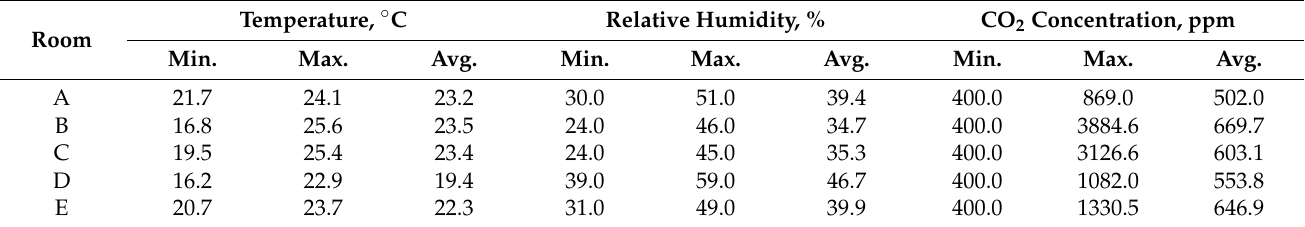
Table 5. Basic statistical data of the collected data for individual